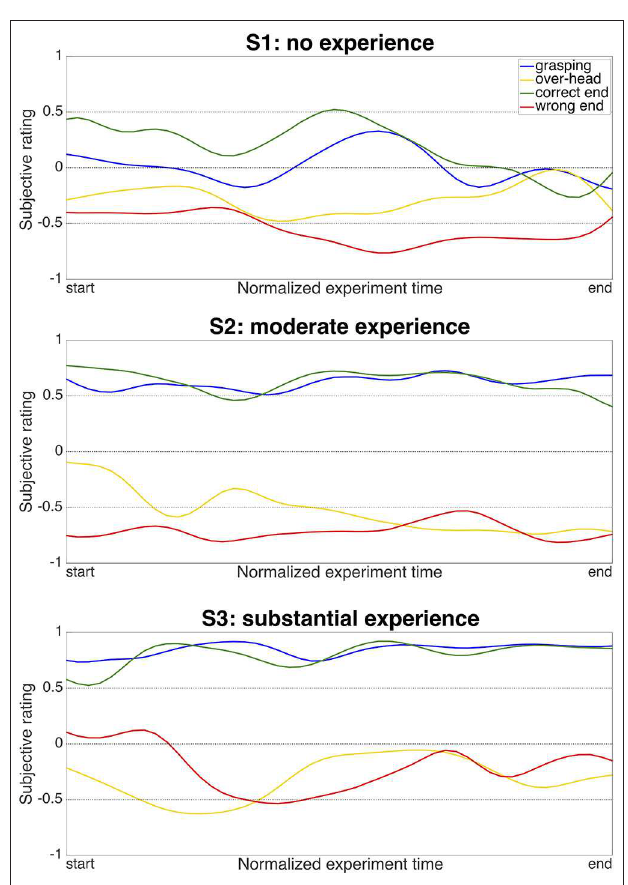
FIGURE 6 | Development of ratings at key robot positions during the experiment. The y-axis shows the subjective rating when the robotic hand was positioned for grasping (blue), in an over-head position (yellow), at the correct end-position for delivery (green), or at a wrong, too-high end-position (red). The x-axis shows the development of the ratings over the duration of the experiment. The ratings are smoothed with a moving-average filter consisting of a Gaussian weighted window with the size of 1 5 th of the total samples per condition, which was convolved with the raw ratings.